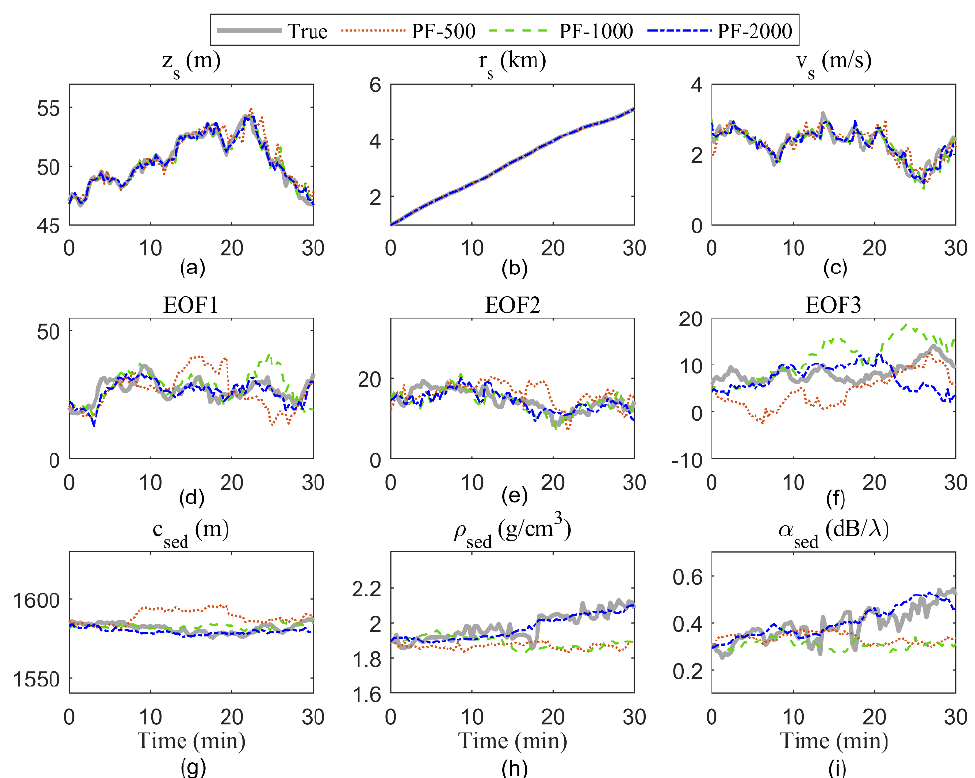
Figure 8. Improved PF tracking results of different particle sizes: ( a-c ) for source parameters, ( d-f ) for three EOFs, ( g-i ) for sediment parameters True trajectories (thick solid line) are provided along with the PF estimates (dashed, dotted, and dashed–dotted lines). Table 5. TARMSE of improved-PFs for ASIAEX tracking